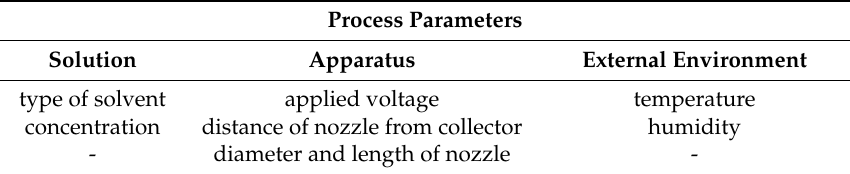
Table 6. Process parameters affecting the electrospinning